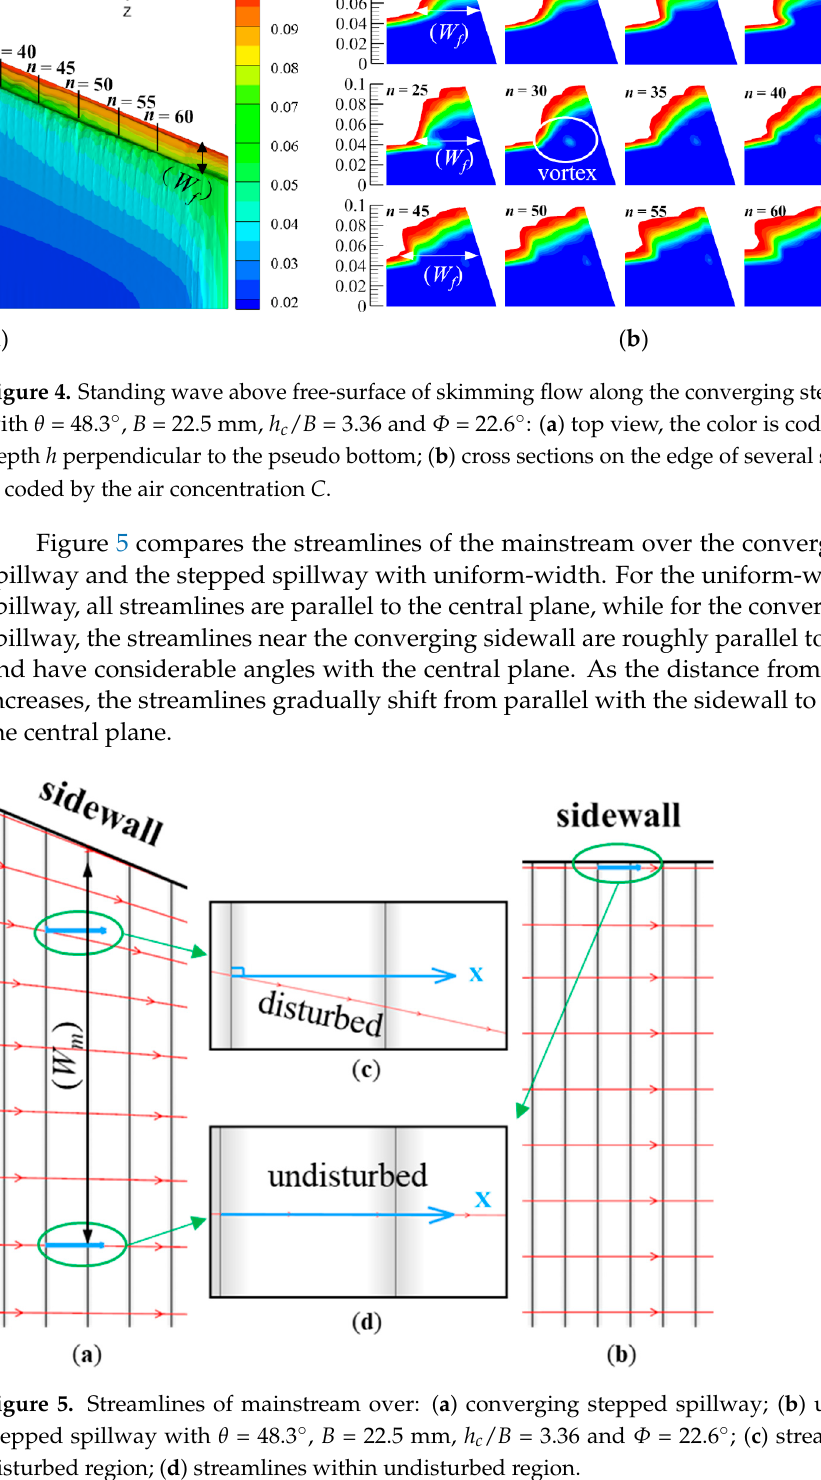
Figure 3. Typical skimming flow pattern of the converging stepped spillway with θ = 48.3°, B = 22.5 mm, h c / B = 3.36 and Φ = 22.6°. Blue surface: free-surface; red lines: mainstream; g reen and blue ro- tating lines: bottom rotations.